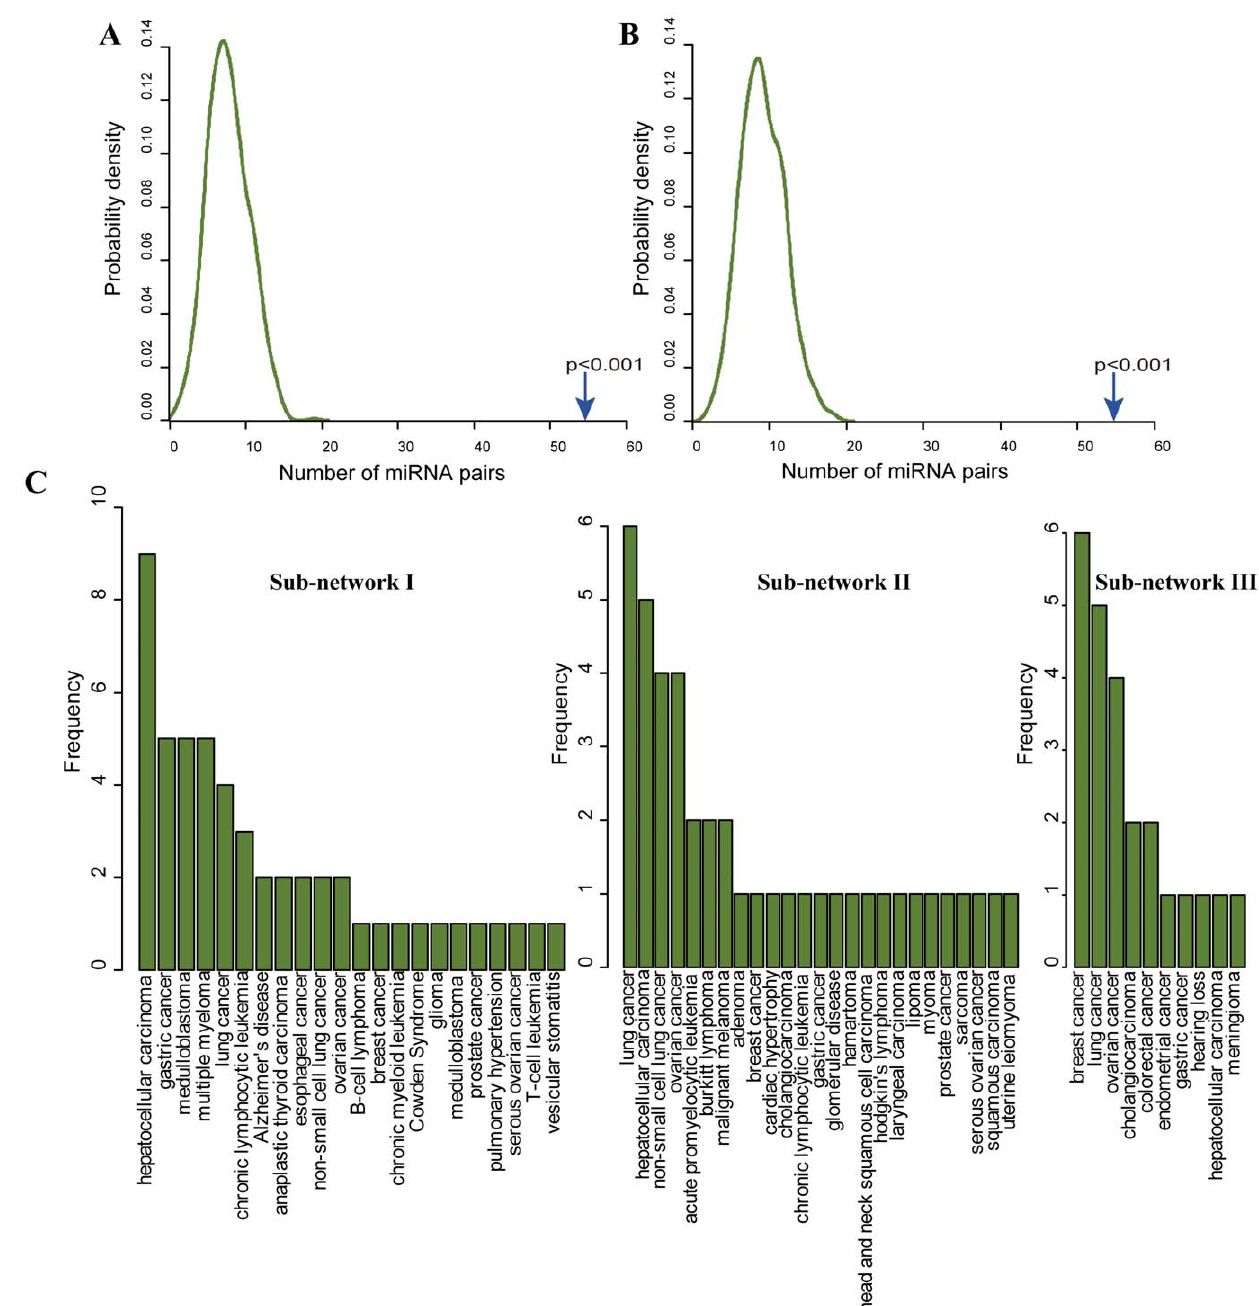
Figure 3. Dysfunction of multiple co-expressed microRNAs in a common disease. (A) The distribution of the number of miRNA pairs sharing a common disease from random selections of miRNA pairs. The number observed in the real conserved co-expression pairs (located by the blue arrow) is significantly higher than those in the randomly selected miRNA pairs ( p-value , 0.001). (B) The distribution of the number of miRNA pairs sharing a common disease from random selections of disease miRNAs. The number observed in the real conserved co-expression pairs (located by the blue arrow) is significantly higher than those from the randomly selected disease miRNAs ( p-value , 0.001). (C) The numbers of miRNAs associated with different human diseases in each sub-network.